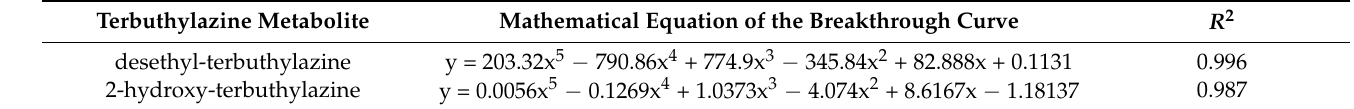
Table 5. Mathematical equations of the breakthrough curve for investigated terbuthylazine metabolites. Terbuthylazine Metabolite